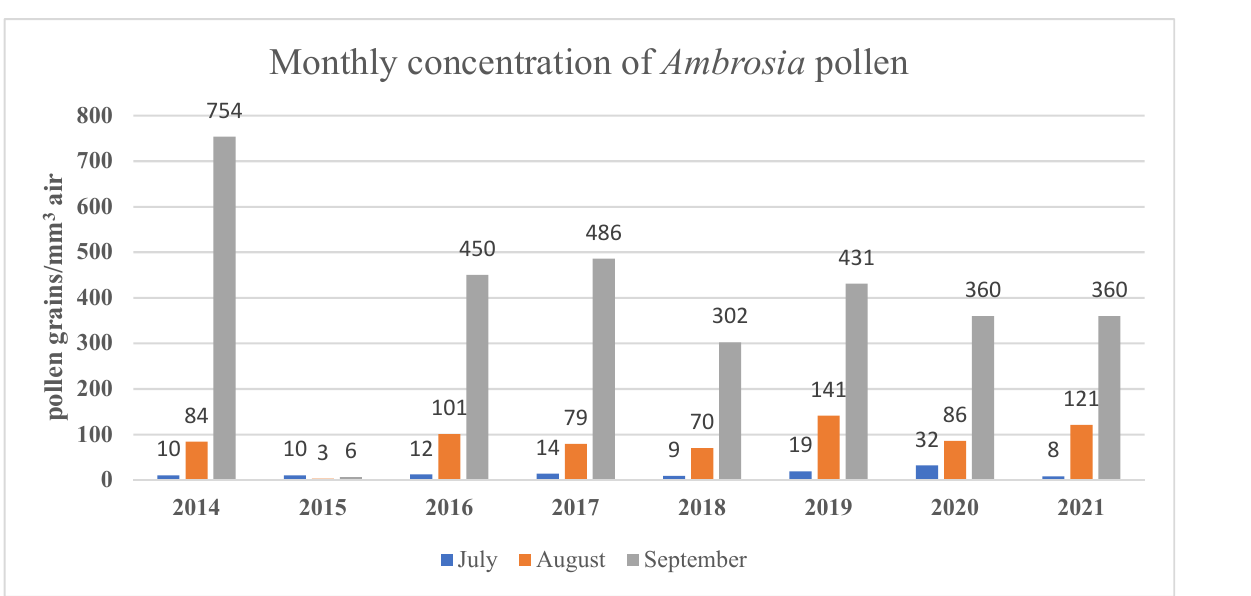
Table 1. Total monthly concentration of Ambrosia pollen between 2014–2021 (pollen grains/mm 3 air).